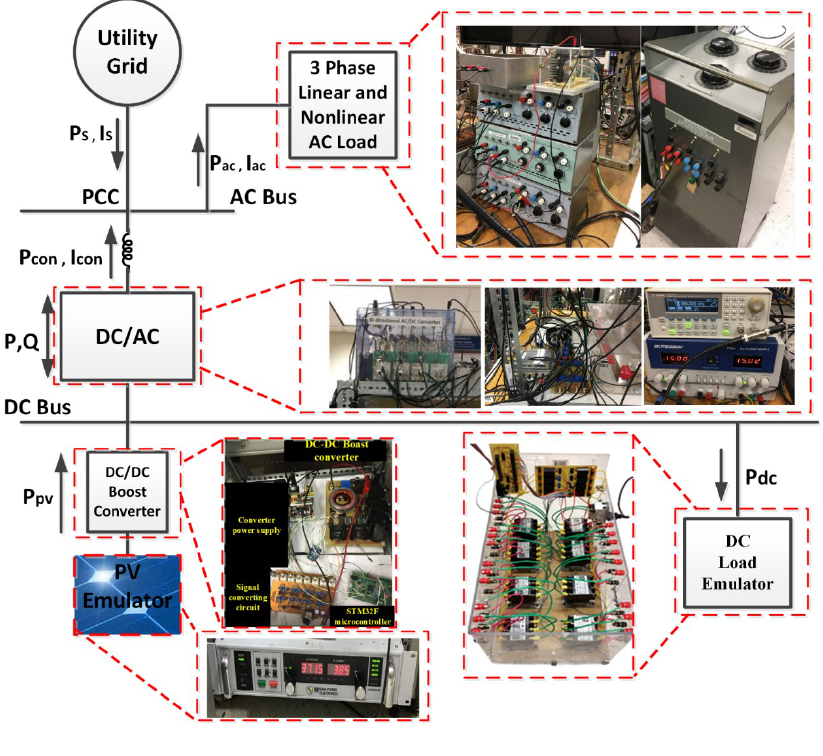
Table 1. The experimental setup